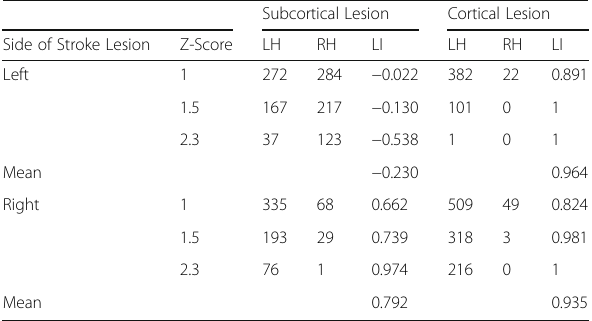
Table 5 (abstract A14). Laterality index using a voxel-count-based method in FSL: a comparison across different stroke lesion profiles and